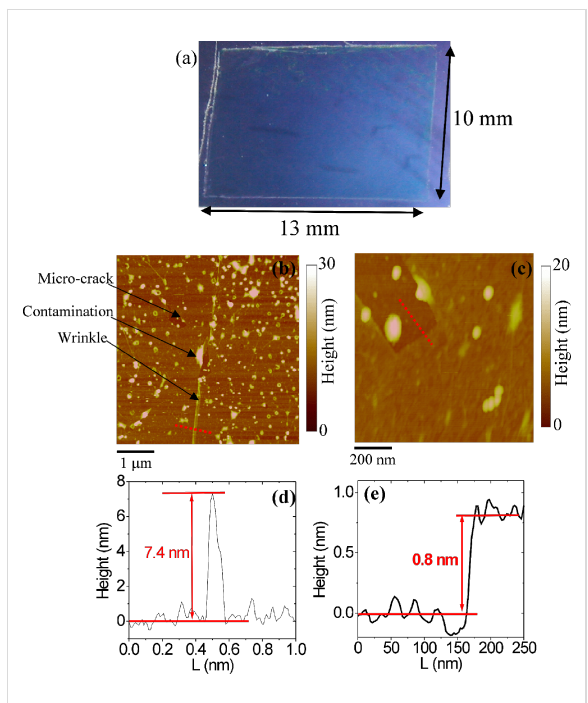
Figure 2: Optical image of a (13 × 10) mm 2 graphene membrane transferred onto SiO 2 (a), and AFM morphologies at (5 × 5) μ m 2 (b) and (1 × 1) μ m 2 (c) magnifications. Line scans on a peculiar corruga- tion of the graphene membrane (d) and across a microscopic crack (e).